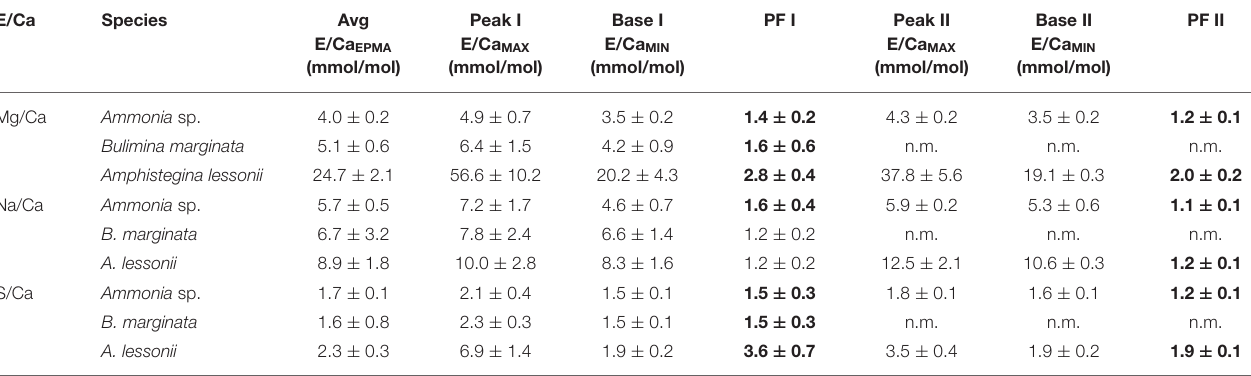
TABLE 3 | EPMA average values (see Table 2 ) and E/Ca MAX and E/Ca MIX values in mmol/mol for Ammonia sp. T6, Bulimina marginata , and Amphistegina lessonii with peak factor (PF; significant values, p < 0.05, in bold, see Table 4 ). E/Ca